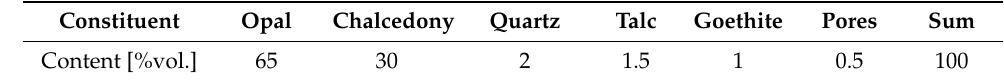
Table 2. Opal aggregate